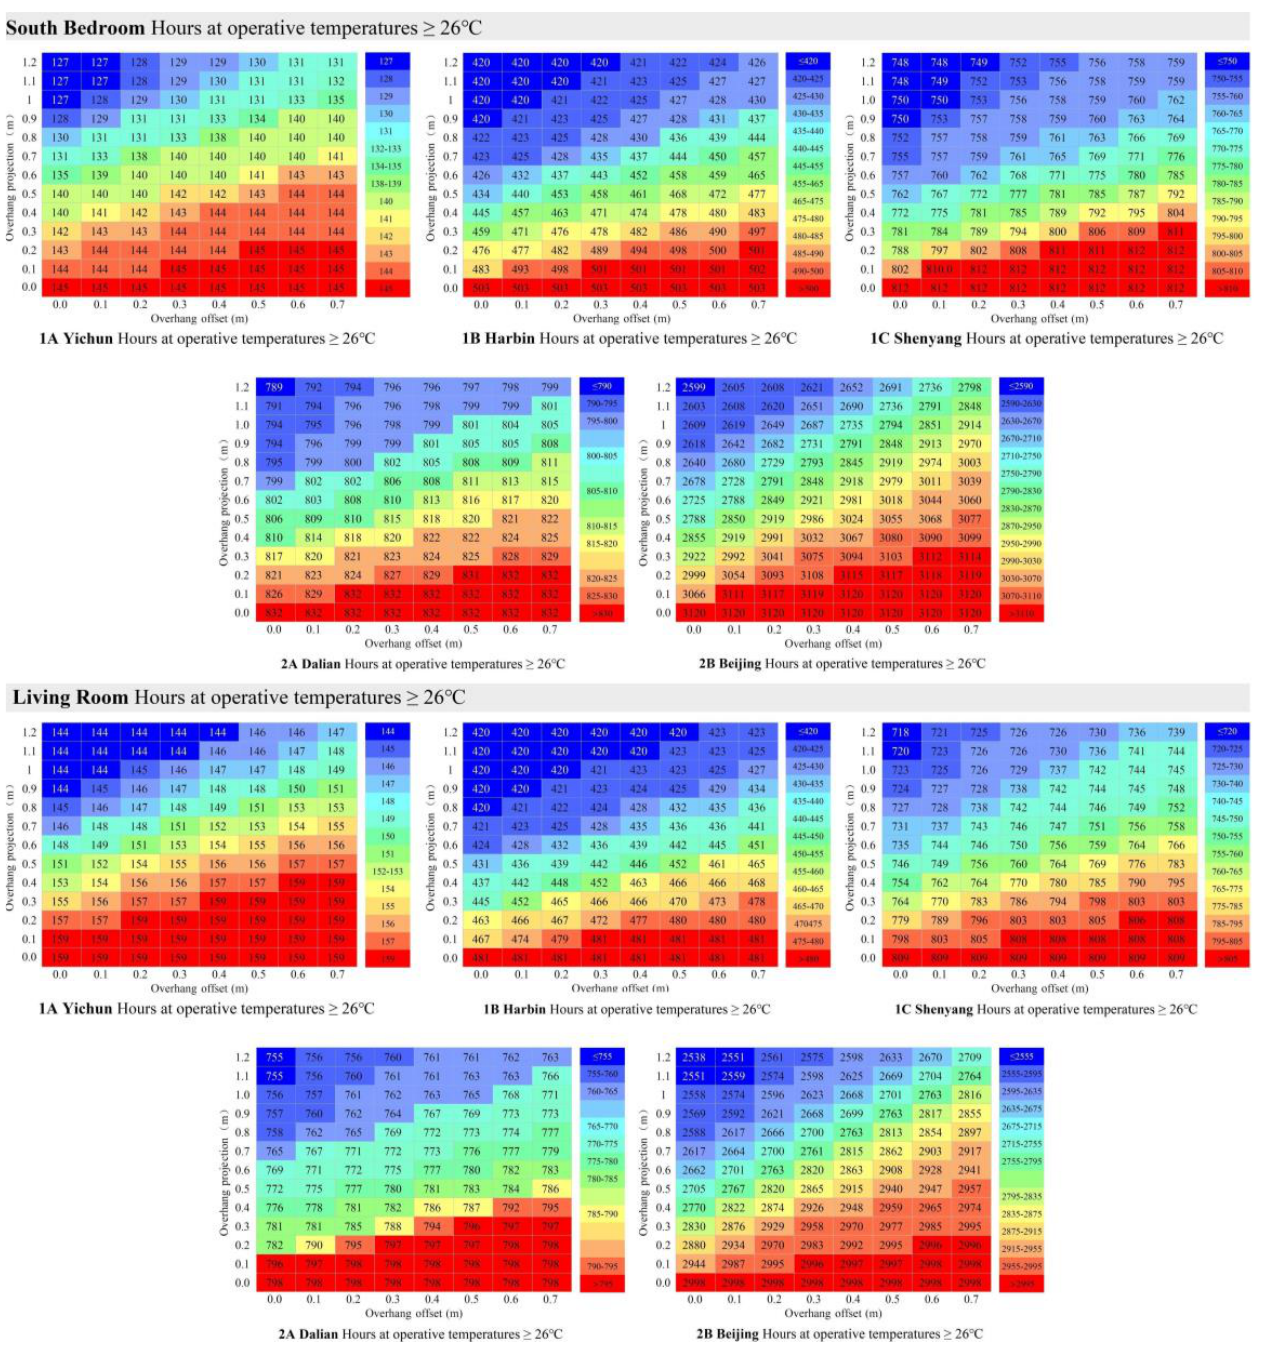
Figure 12. The number of hours where the operative temperature exceeds 26 °C.